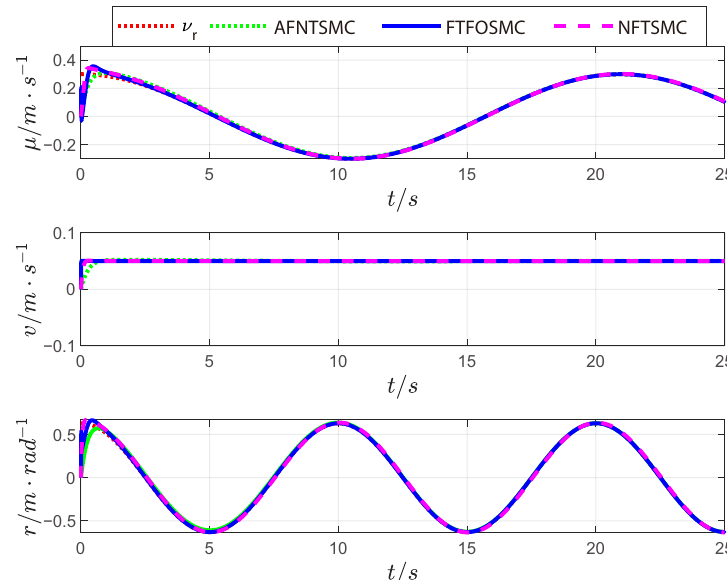
Figure 5. Speed tracking curve.